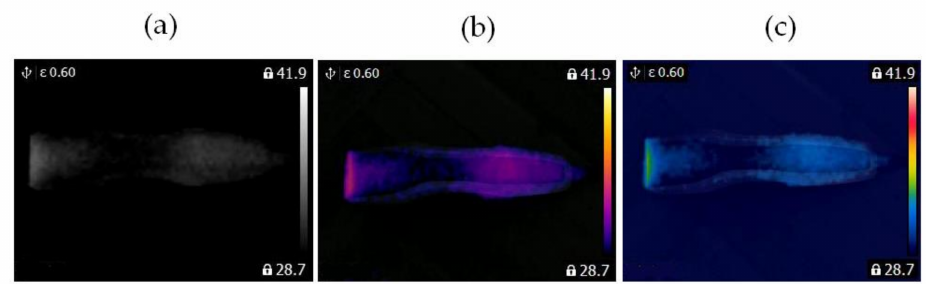
Figure 10. Blocked ventilation of the clipper: ( a ) gray-scale, ( b ) iron scale, ( c ) rainbow scale.